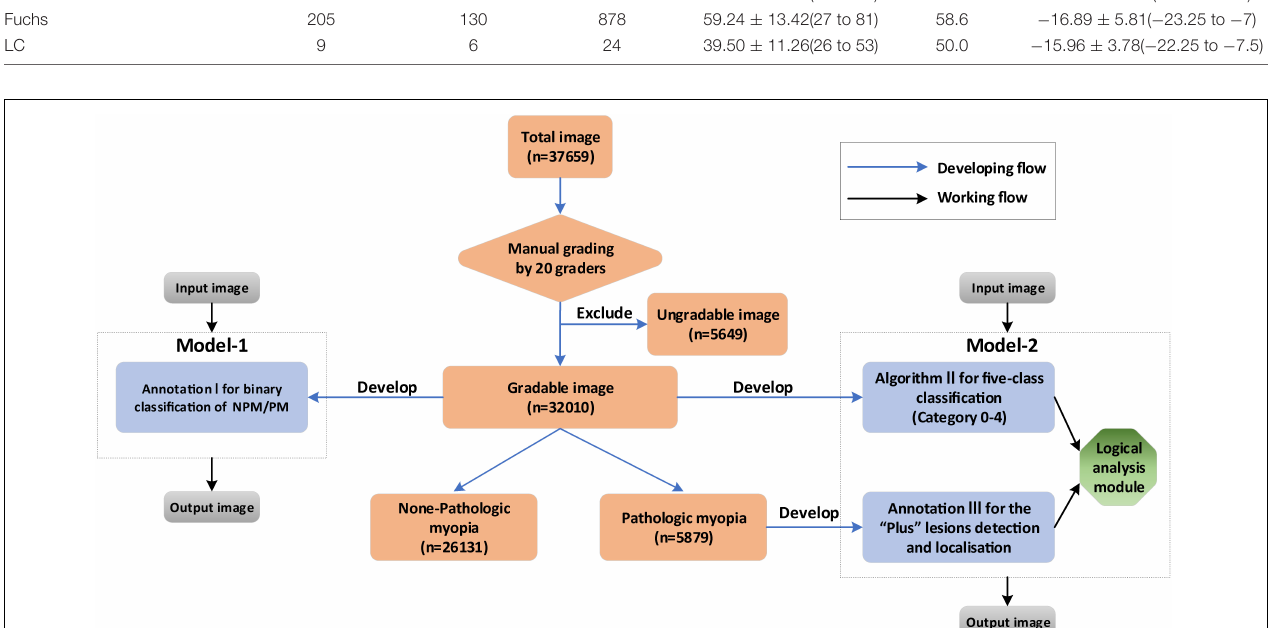
FIGURE 1 | The diagram showing the detailed developing and working flow of our algorithms and artificial intelligence (AI)–models.